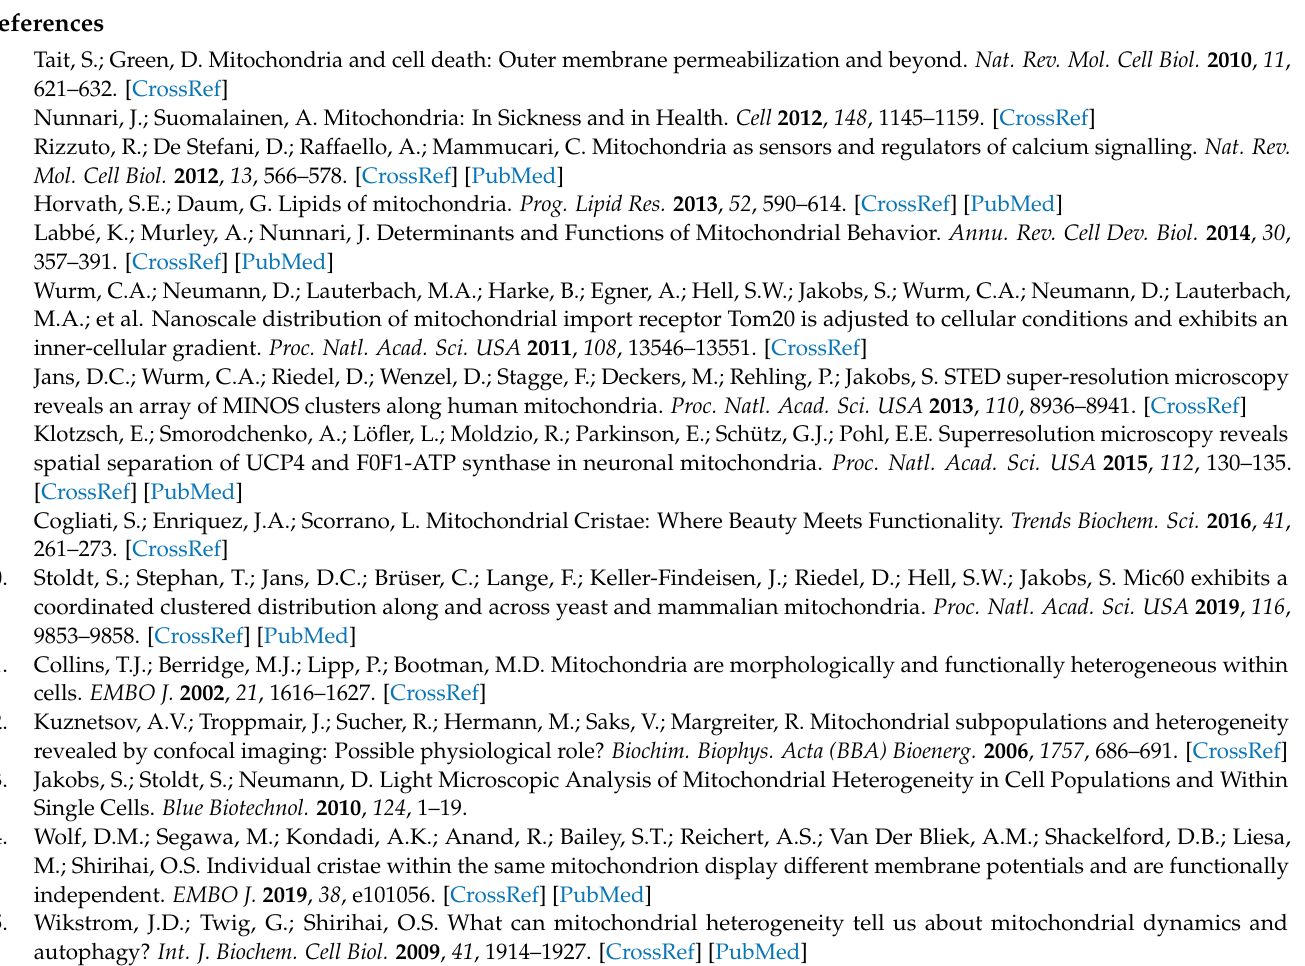
Each grey rhomb represents one cell. Black dot: mean. Error bars: Standard error of the mean. Scale bars: 40 µ m ( A , B